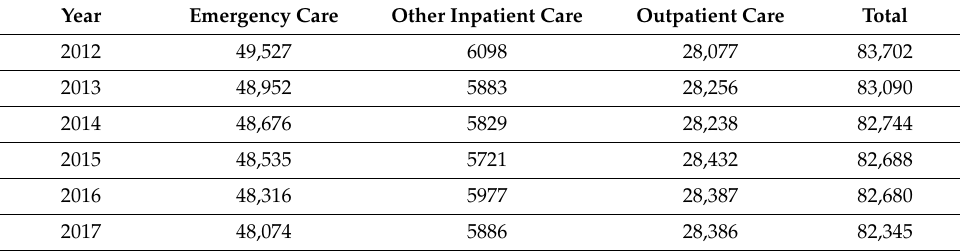
Table 2. Development in the number of nurses and midwives, 2012–2017, with an outlook to 2030. Year Emergency Care Other Inpatient Care Outpatient Care